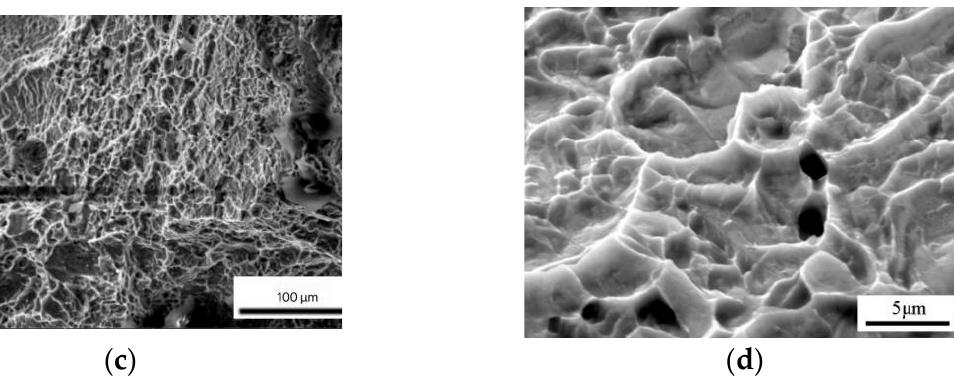
Figure 12. Fracture surface morphology: ( a ) bypass hot wire plasma arc overview welding joint, ( b ) bypass hot wire plasma arc center zone welding joint, ( c ) traditional filler wire plasma arc overview welding joint, and ( d ) traditional filler wire plasma arc center zone welding joint.